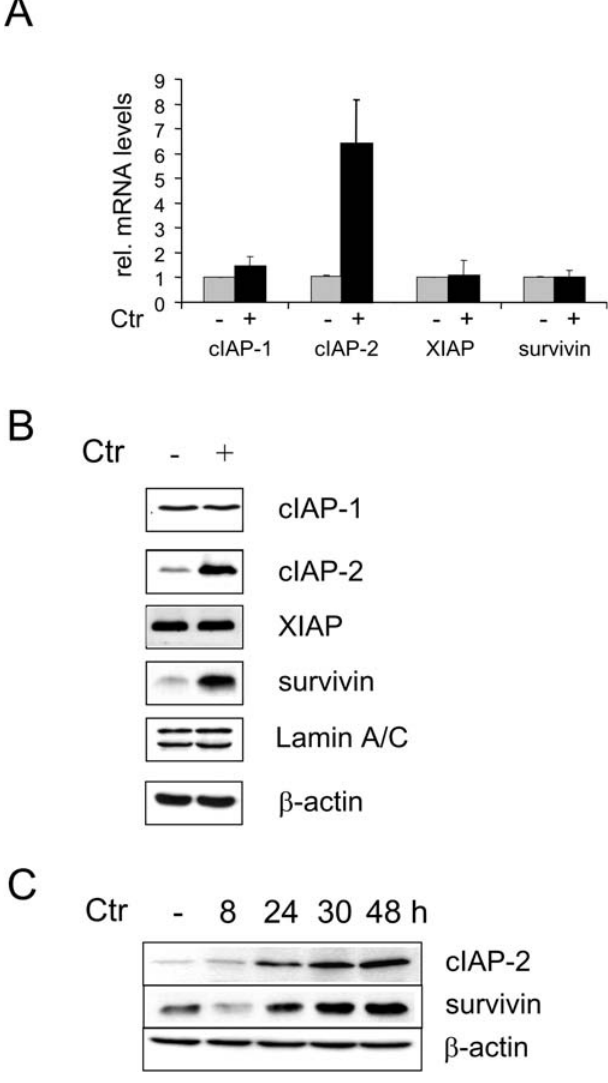
Figure 2. Infection-Induced Up-regulation of cIAP-2 (A) mRNA levels of different IAPs were monitored by qRT-PCR in HeLa cells infected ( þ ) or not ( (cid:1) ) with Ctr. The amount of cIAP-2 mRNA increases strongly in infected cells. (B) The level of IAP expression was determined by immunoblot analysis in noninfected ( (cid:1) ) and infected ( þ ) cells. Note that cIAP-2 and survivin are strongly up-regulated in infected cells. (C) Time course of cIAP-2 and survivin up-regulation was tested in infected cells by immunoblot analysis. Cells were infected and lysed at different time points postinfection as indicated. DOI: 10.1371/journal.ppat.0020114.g002 PLoS Pathogens |